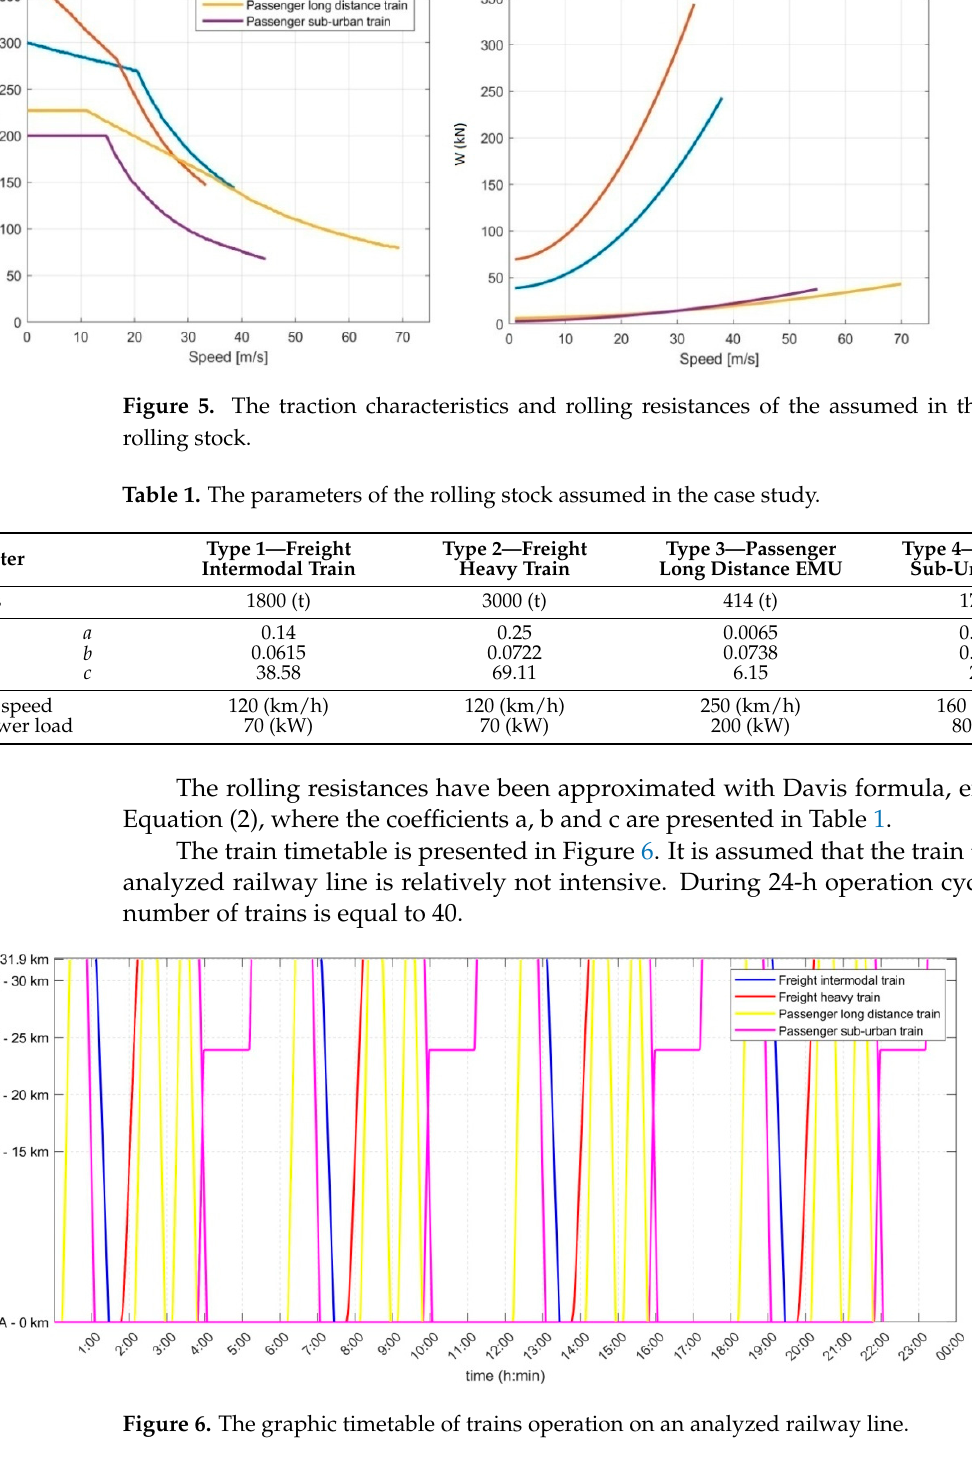
Figure 6. The graphic timetable of trains operation on an analyzed railway line .